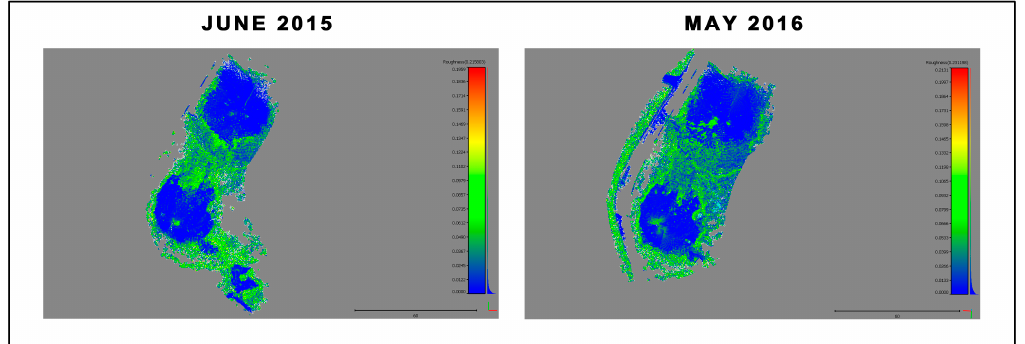
Figure 7. Roughness point cloud analysis performed with Cloud Compare on the Area 3 of the Nirano Natural